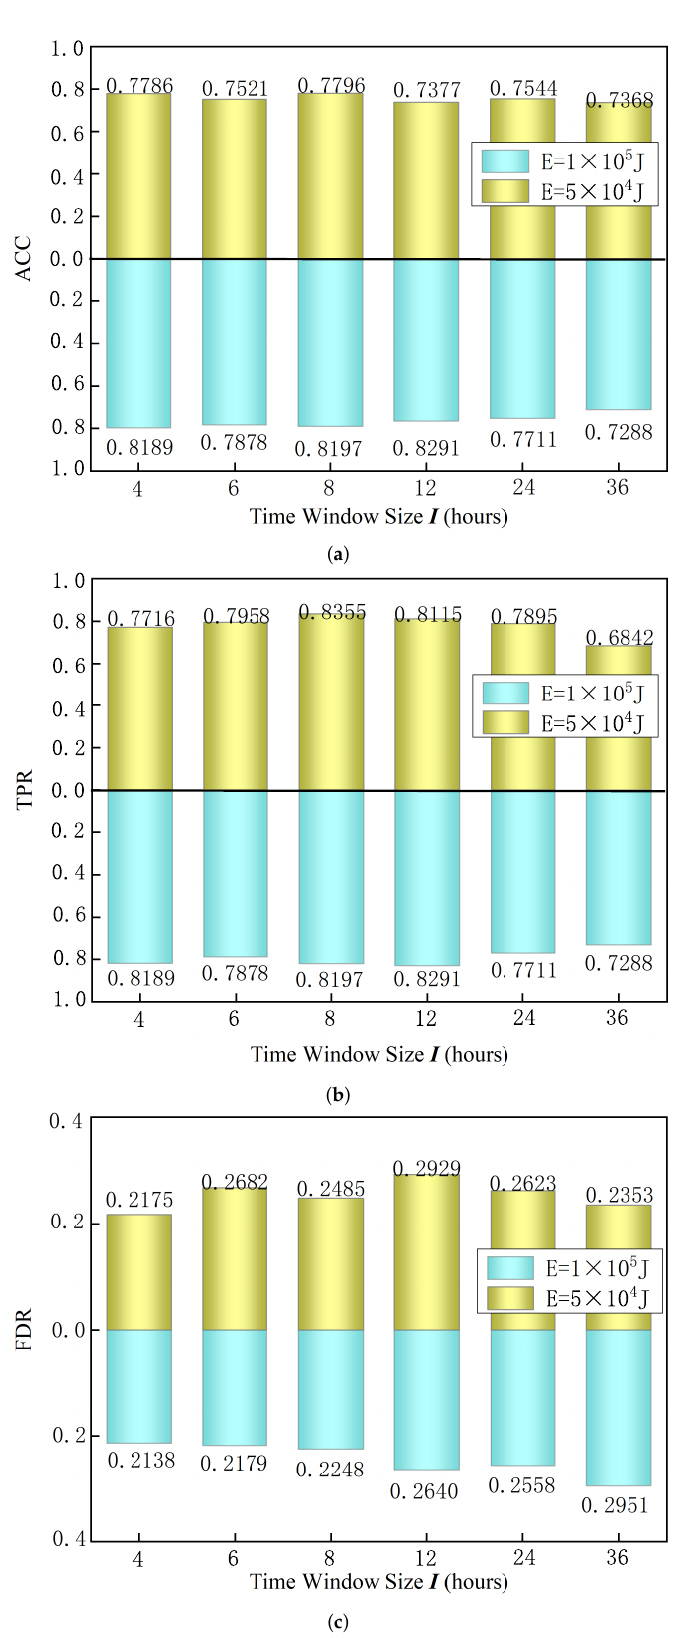
Figure 7. Test results of different time window sizes including ( a ) ACC, ( b ) TPR, ( c )